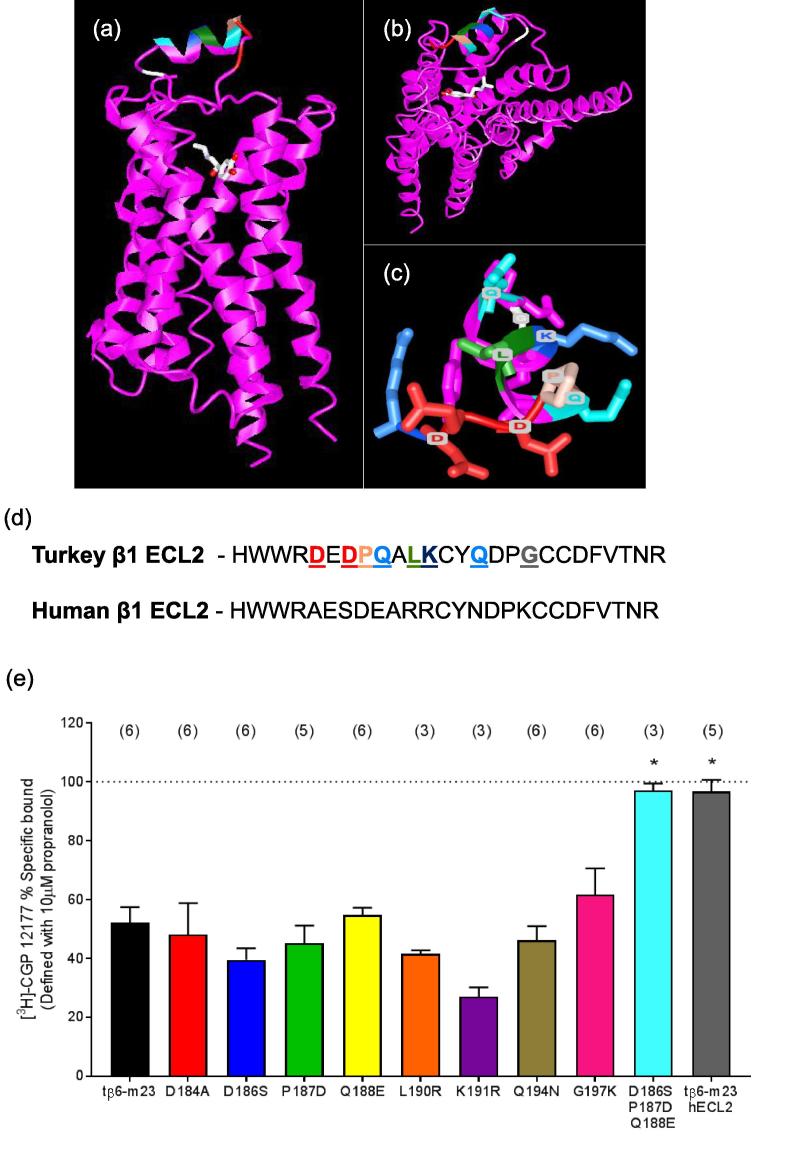
Ribbon representation of the β1AR-m23 StaR structure bound to isoprenaline (PDB ID: 2Y03; [39]) generated with Cn3D (National Centre for Biotechnology Information). (a) Side view and (b) top view of receptor highlighting the ECL2 residues (coloured as in (d)) which differ between the turkey and human β1-AR sequences. The structure of isoprenaline is also shown. (c) Top view of ECL2 with side chains of residues (coloured) that differ from the human β1-AR sequence. (d) Amino acid sequence of ECL2 for turkey and human β1-AR, with residue differences highlighted. (e) Specific binding of 0.5–2.5 nM [3H]-CGP 12177 in the presence of 1 µM mAb3 in CHO cells transiently expressing wildtype tβ6-m23 or ECL2 mutant constructs (where residues have been changed from the turkey amino acid to their human equivalent). Data are represented as a % of the specific binding of [3H]-CGP 12177 in the presence of mAb3. Non-specific binding was defined with 10 µM propranolol. Data are mean ± s.e.m. The number of separate experiments performed for each mutant are given in parentheses above each bar. Triplicate determinations were performed in each individual experiment. *p < 0.05 comparing the inhibition specific binding by 1 µM mAb3 in that ECL2 mutant to the wild-type receptor, one-way ANOVA. (For interpretation of the references to colour in this figure legend, the reader is referred to the web version of this article.)